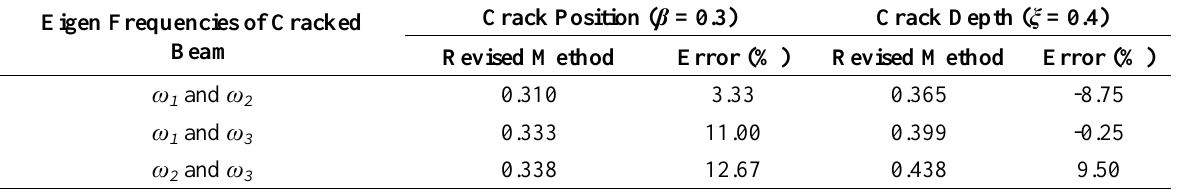
Table 2. Crack parameters obtained from proposed method (compressive load) Eigen Frequencies of Cracked